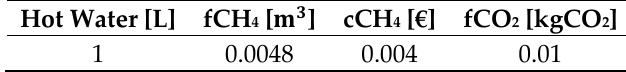
Table 1. Methane gas multiplier coefficients: fCH 4 define the amount of methane for 1 L of hot water, cCH 4 is the methane cost multiplier and fCO 2 is CO 2 multiplier coefficients refers to methane gas combustion.